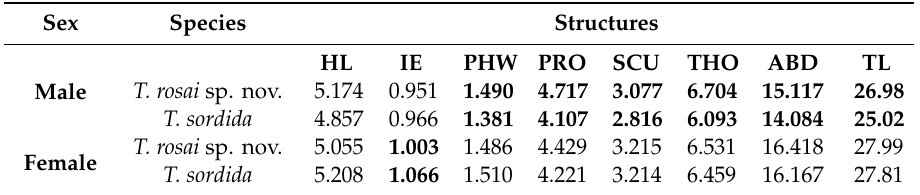
Table 2. Measurement averages and significance of T. sordida sensu stricto and T. rosai sp. nov. In bold, we present statistically significant measurements.